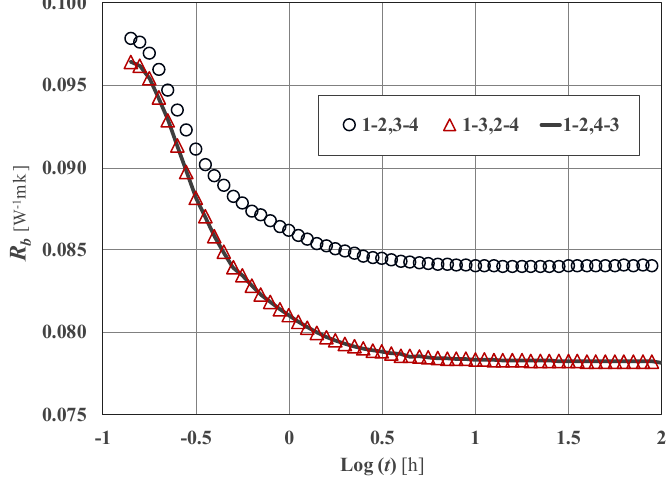
Figure 7. The borehole thermal resistance versus logarithmic scale of time.